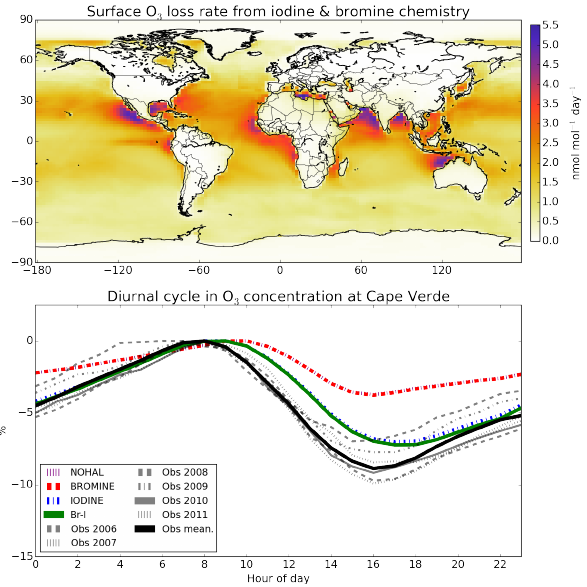
Figure 15. Global annual mean surface O 3 loss (nmolmol − 1 day − 1 ) in the “Br + I” simulation from both bromine and iodine (top). Comparison between modelled and observed fractional diurnal O 3 cycles at the Cape Verde Observatory for “NOHAL”, “BROMINE”, “IODINE”, and “Br + I” simulations (bottom). The calculation is described in Sect. 6. Diurnal changes are averaged over the whole data set. Lines are black, purple, red, blue, and green for mean of observations, “NOHAL”, “BROMINE”, “IODINE”, and “Br + I” respectively. Individual years of observational data are shown in